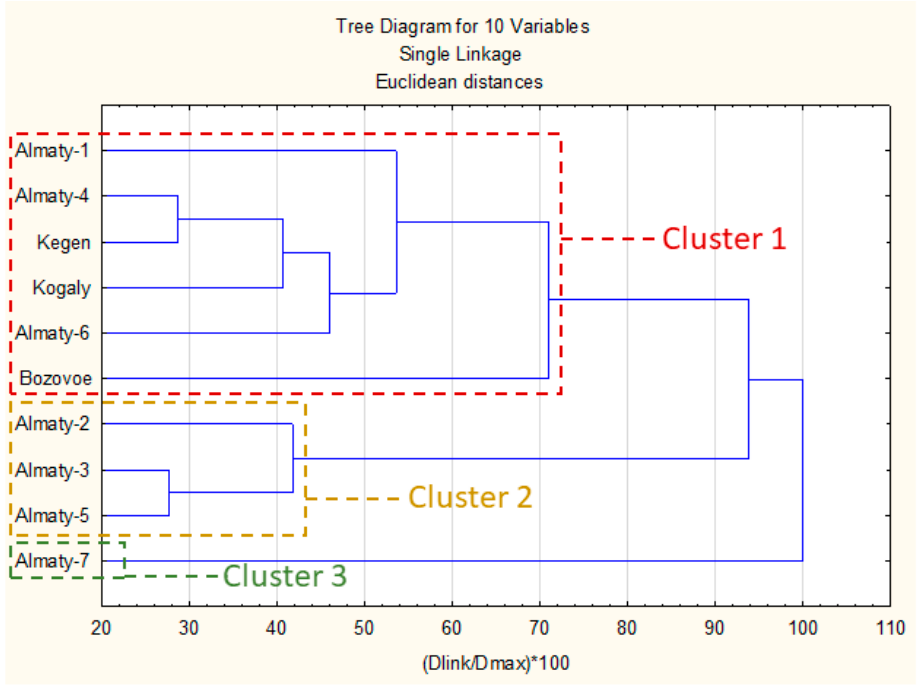
Figure 2. Dendrogram of Kazakh propolis chemical composition. Figure legend: Dlink—Linkage Distance; D max—Maximal distance.